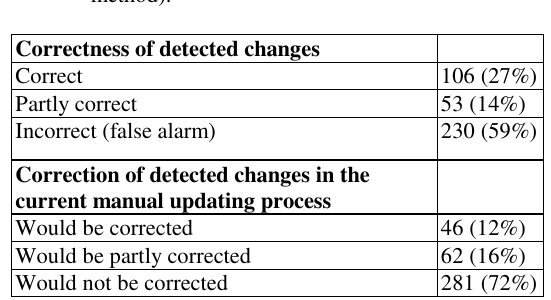
Visual analysis on the correctness of automatically detected changes (not the newest version of the